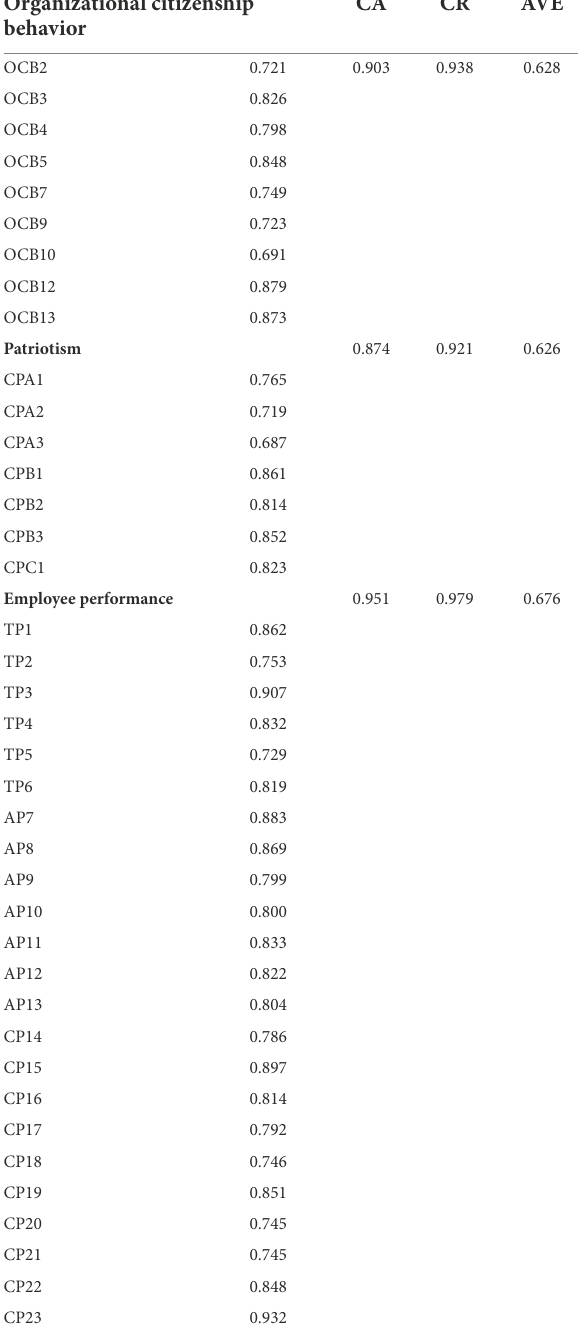
TABLE 3 Constructs/items measurement properties. Organizational citizenship